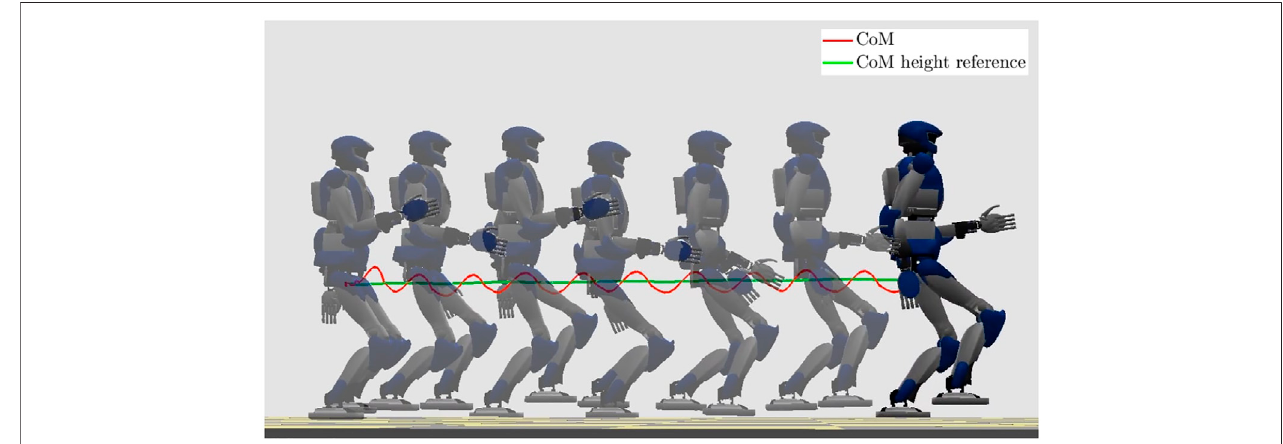
FIGURE 11 | Running on fl at ground: stroboscopic